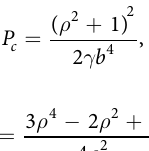
Solitons can be found as the extrema of the potential V ( b , c ). By setting ∂ V / ∂ b = 0 and ∂ V / ∂ c = 0, we can obtain the critical power and the critical OAM